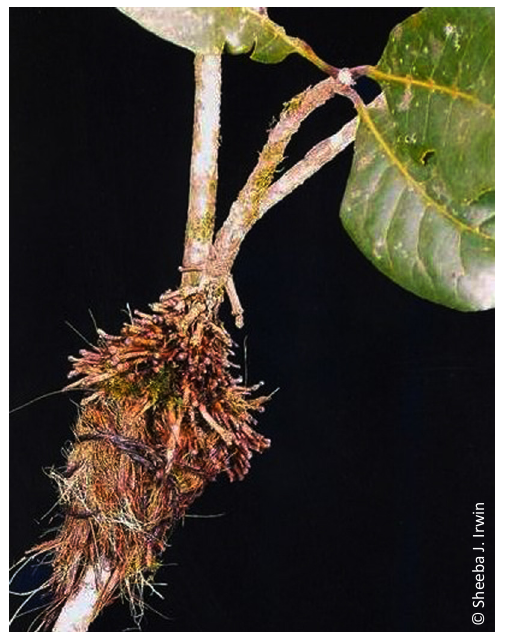
Image 5. Air-layered